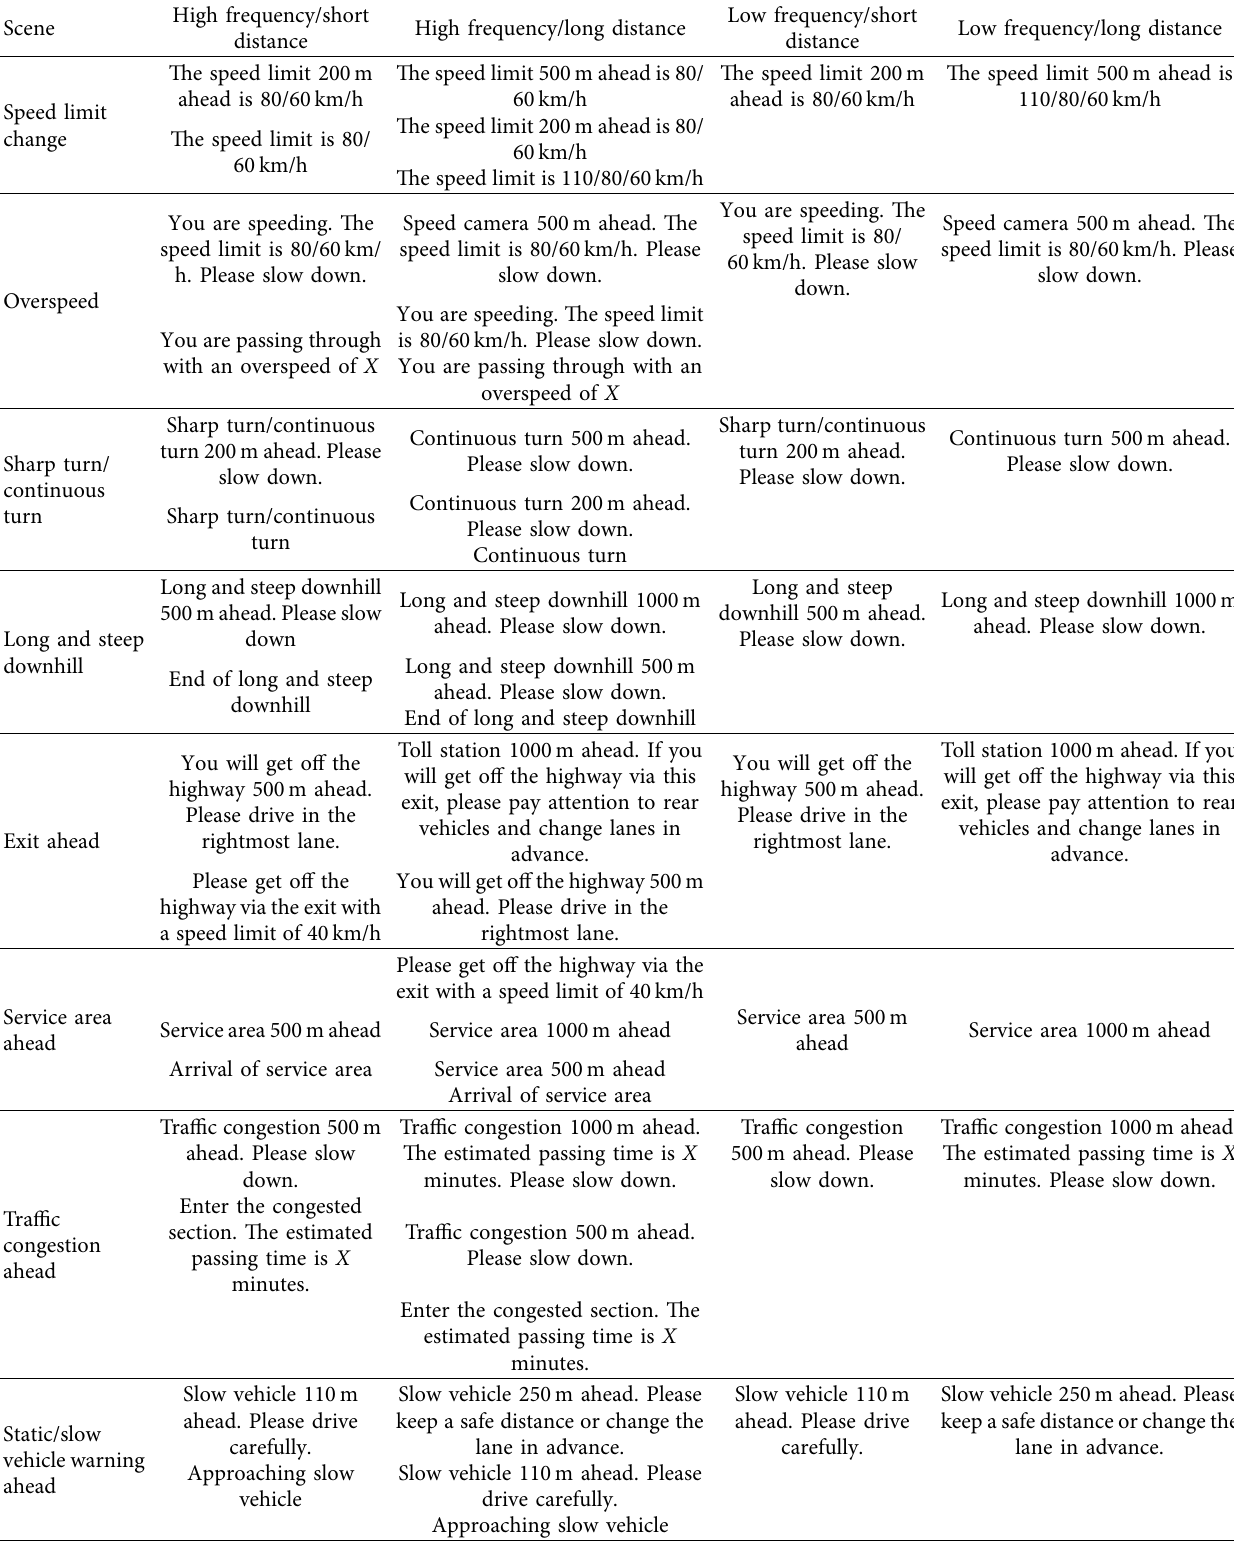
Table 2: Content of voice broadcast under various combinations of trigger timing and trigger frequency.